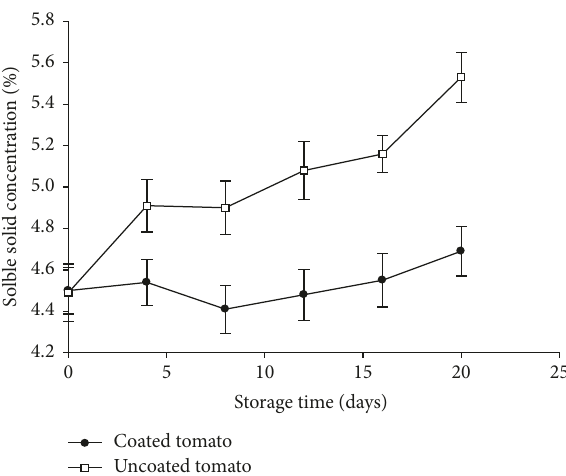
Figure 4: Influence of guar gum coating on the soluble solid concentration of Roma tomatoes during a 20-day storage period ( 22 ± 2 ∘ C).